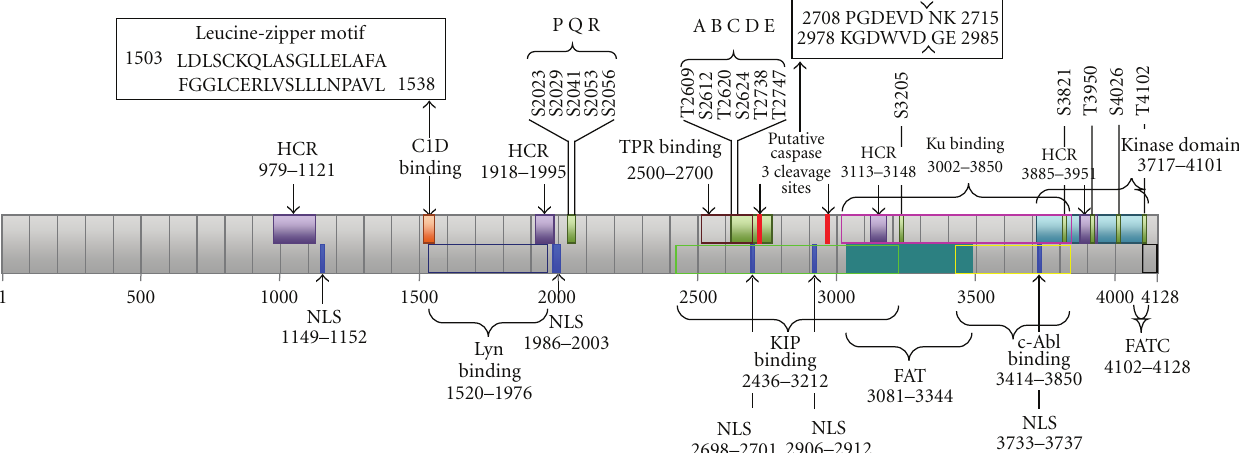
Figure 7: Schematic diagram of DNA-PKcs sequence-function implications. Shown are four highly conserved regions (HCR) [49]; Kinase, FAT, and FATC domains; putative sites for nuclear localization signals (NLSs) [49]; Autophosphorylation sites PQR [50], ABCDE [19], S3205 [51], S3821, S4026, T4102 [52], and T3950 [53]; cleavage sites for apoptotic protease caspase-3 [49, 54–56]; binding sites for Lyn tyrosine kinase [57], C1D protein that interacts at the leucine-zipper motif of DNA-PKcs [58], protein phosphatase-5 (PP5) that binds, using its tetratricopeptide repeat (TPR), to dephosphorylate DNA-PKcs at S2056 and T2609 [59], Ku70/80 that binds to present the damaged DNA double strand ends to DNA-PKcs [60], the kinase interacting protein (KIP) [61], and c-Abl that binds using its SH 3 a binding that is triggered by DNA damage